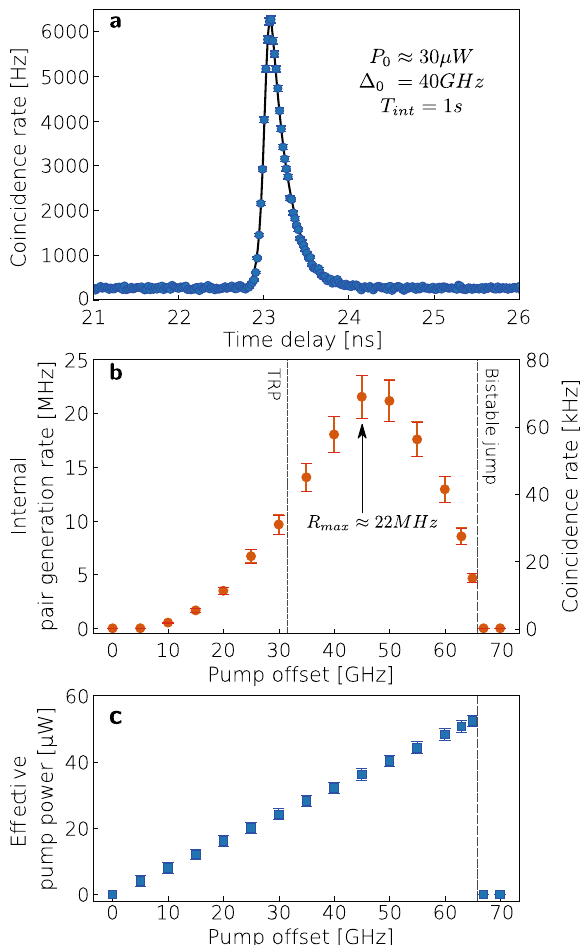
Fig. 2 Time-correlated photon pairs. a Coincidence histogram (blue squares) obtained for an effective pump power in the cavity of P 0 ≈ 30 μ W after T int = 1 s of integration. Δ 0 is the pump offset. The main peak is thus fi tted (black line) using the model (detailed in Methods: Coincidence peak fi tting) to extract the number of coincidences. b On-chip pair generation rate R and the corresponding coincidence rate R det as a function of Δ 0 . Vertical lines denote the point of triply resonant con fi guration (TRP) and bistable jump. The black arrow indicates the maximal measured internal generation rate R max . Error bars are due to uncertainty on the measured coincidence rate, namely a Poisson distribution. c Evolution of the effective pump power P 0 as a function of the pump offset Δ 0